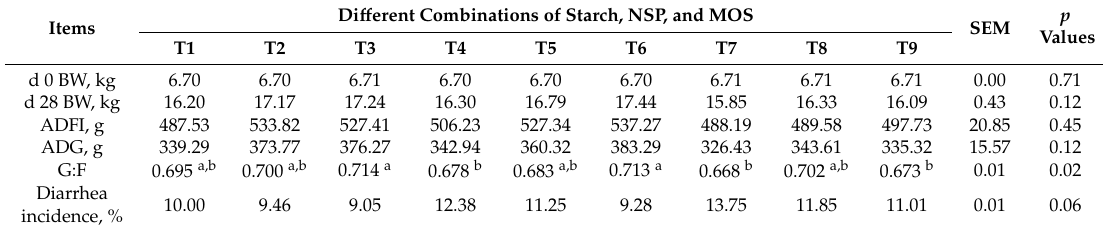
Table 4. E ff ects of di ff erent combinations of starch, NSP, and MOS on the growth performance of weaned pigs.